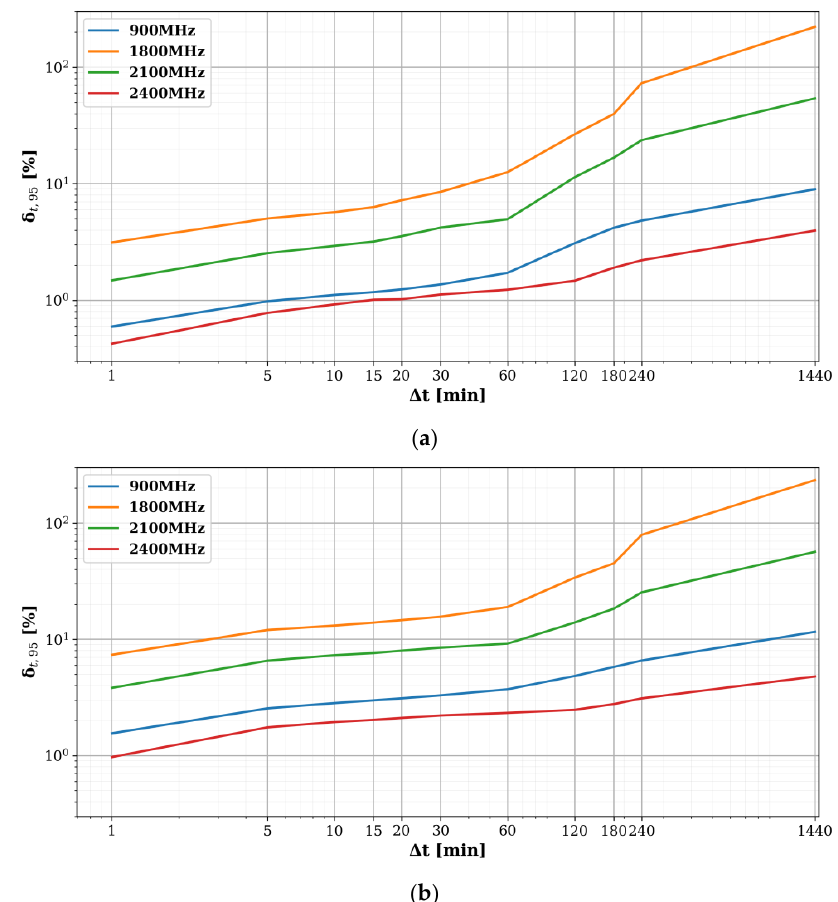
Figure 10. Sensor-averaged 95th percentiles of the relative errors Δ t,95 when comparing ( a ) diurnal (TP D ) and ( b ) weekly temporal profiles (TP W ) with different resolutions Δ t to the baseline TP with Δ t = 30 s (Figures 7 and 8). Δ t = 1440 min (= 24 h) indicates the induced error when using only daily averages.